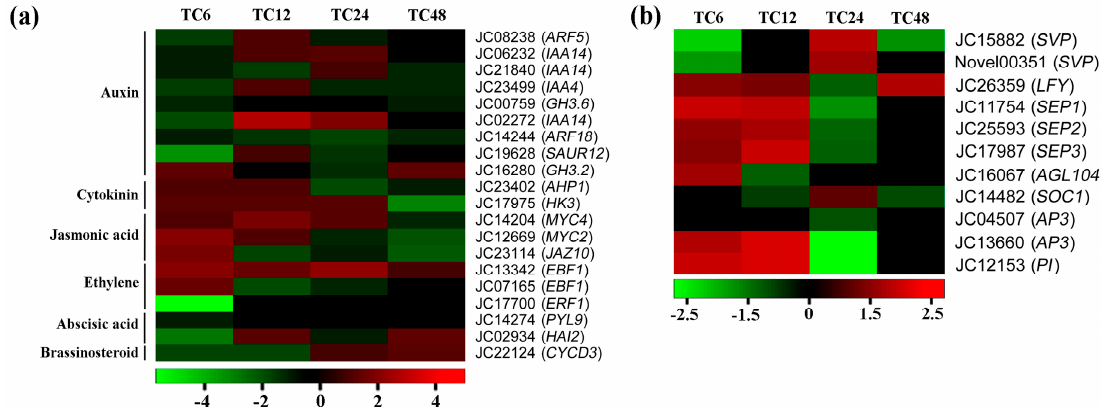
Figure 7. The heat-map of the DEGs related to the other plant hormone-signaling transduction pathways and MADS-box transcription factors after GA 3 treatment in J. curcas . ( a )The heat-map of the DEGs involved in the other plant hormone-signaling transduction pathways; ( b ) the heat-map of the DEGs associated with MADS-box transcription factor. The color was log 2 (Fold change) of the DEGs in different comparison, red is upregulated and green is down regulated.